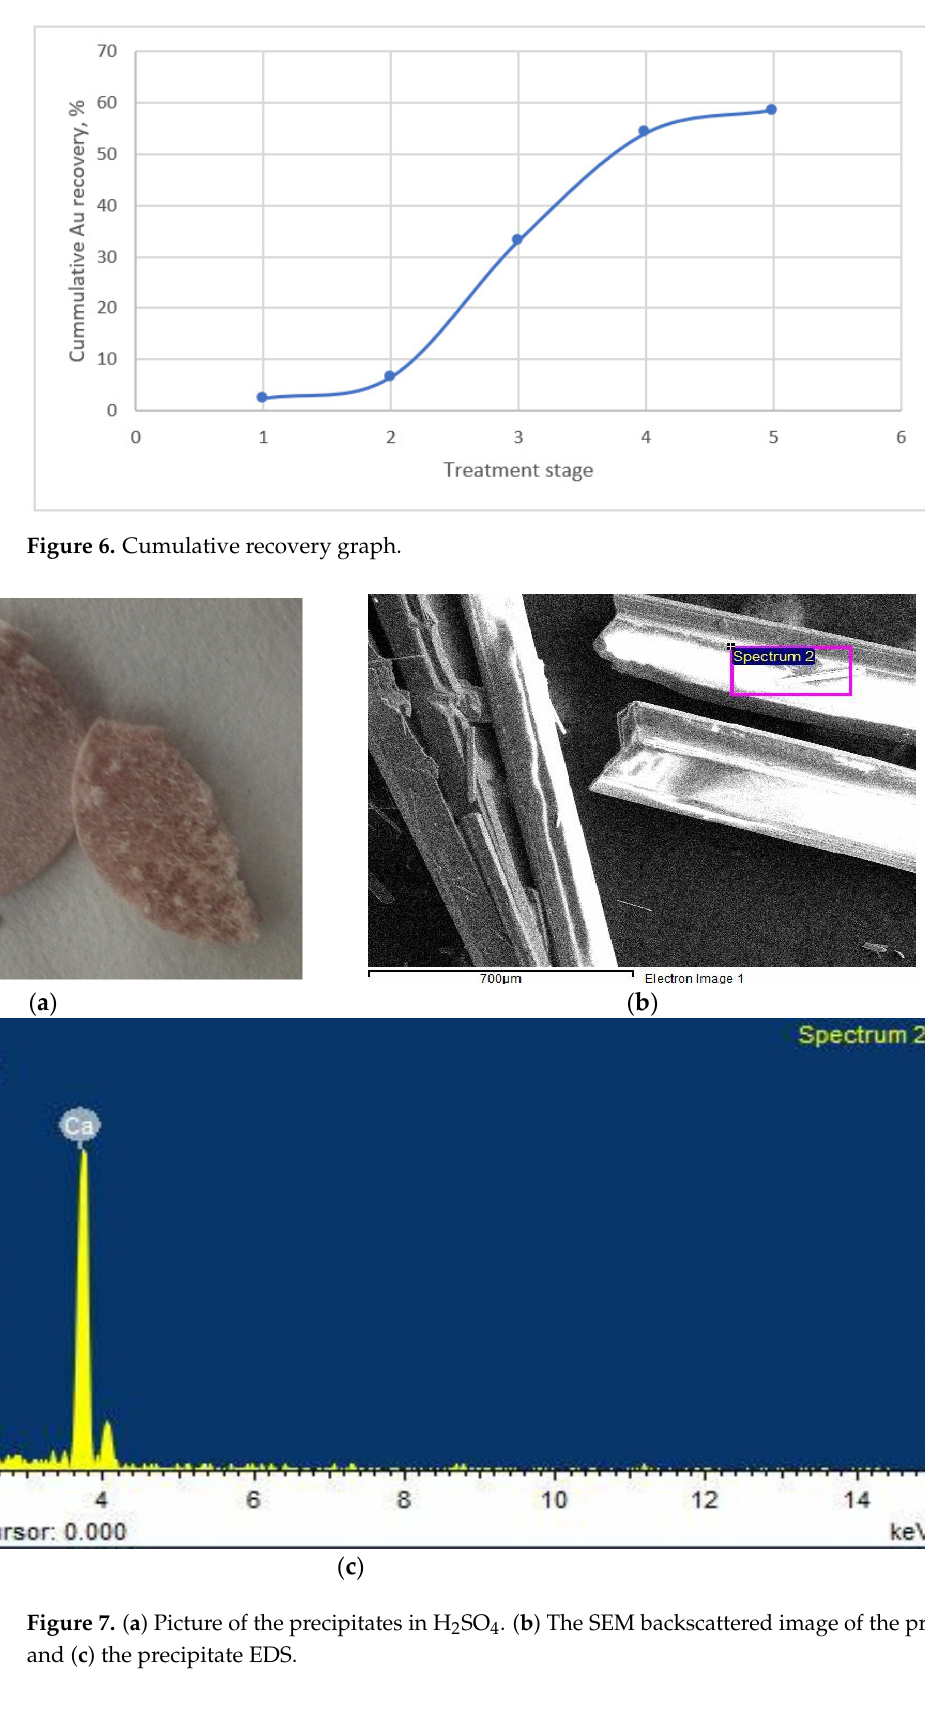
Figure 5. Recovery of gold after each acid pretreatment stage.